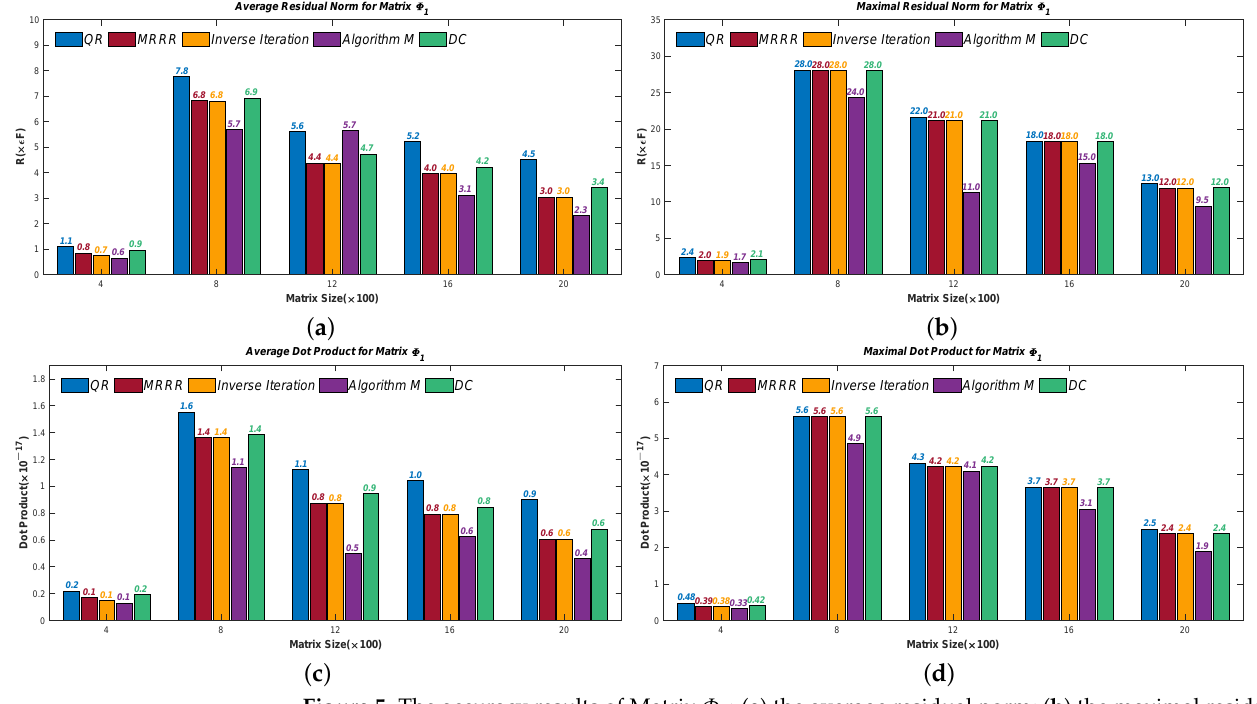
Figure 5. The accuracy results of Matrix Φ 1 : ( a ) the average residual norm; ( b ) the maximal residual norm; ( c ) the average dot product; ( d ) the maximal dot